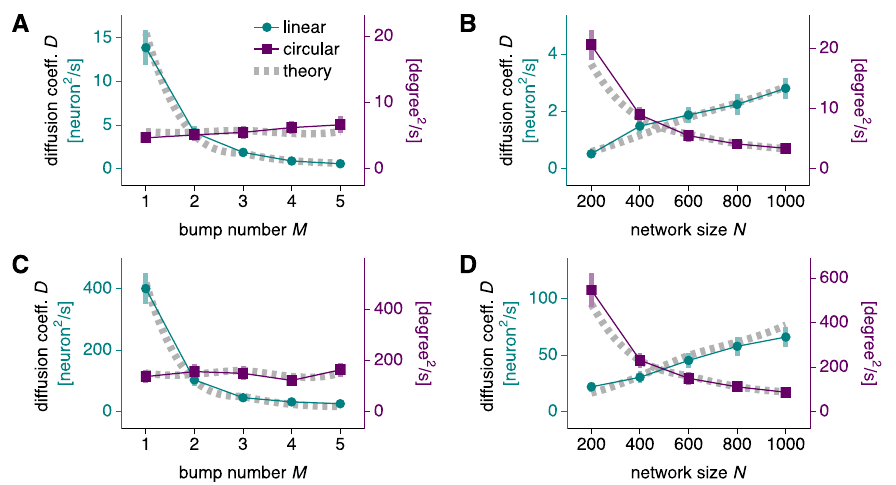
Fig 5. Bump diffusion due to input and spiking noise. ( A, B ) Networks with synaptic input noise of magnitude σ = 0.5 and drive b = 0.5. Dotted gray lines indicate Eq 10. ( A ) Diffusion decreases with bump number under linear mapping and remains largely constant under circular mapping. Networks with 600 neurons. ( B ) Diffusion increases with network size under linear mapping and decreases under circular mapping. Networks with 3 bumps. ( C and D ) Same as A and B , but for networks with Poisson spiking noise instead of input noise. Dotted gray lines indicate Eq 20. Points indicate data from 48 replicate simulations and bars indicate bootstrapped standard deviations.